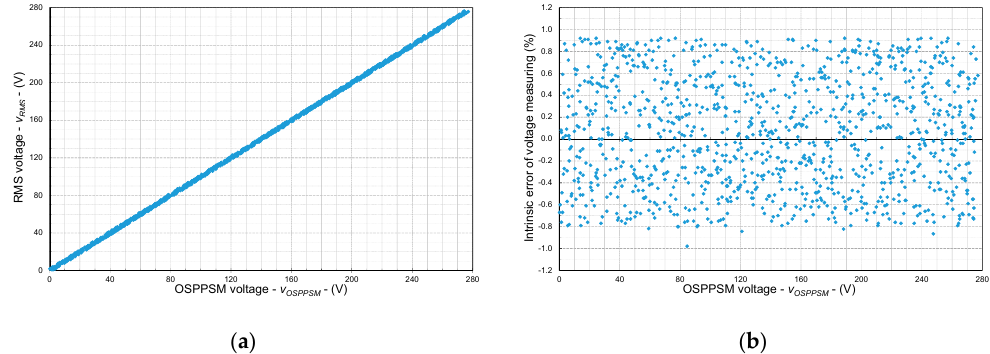
Figure 8. Voltmeter test: ( a ) OSPPSM vs. RMS voltage. ( b ) Intrinsic error of voltage measuring.